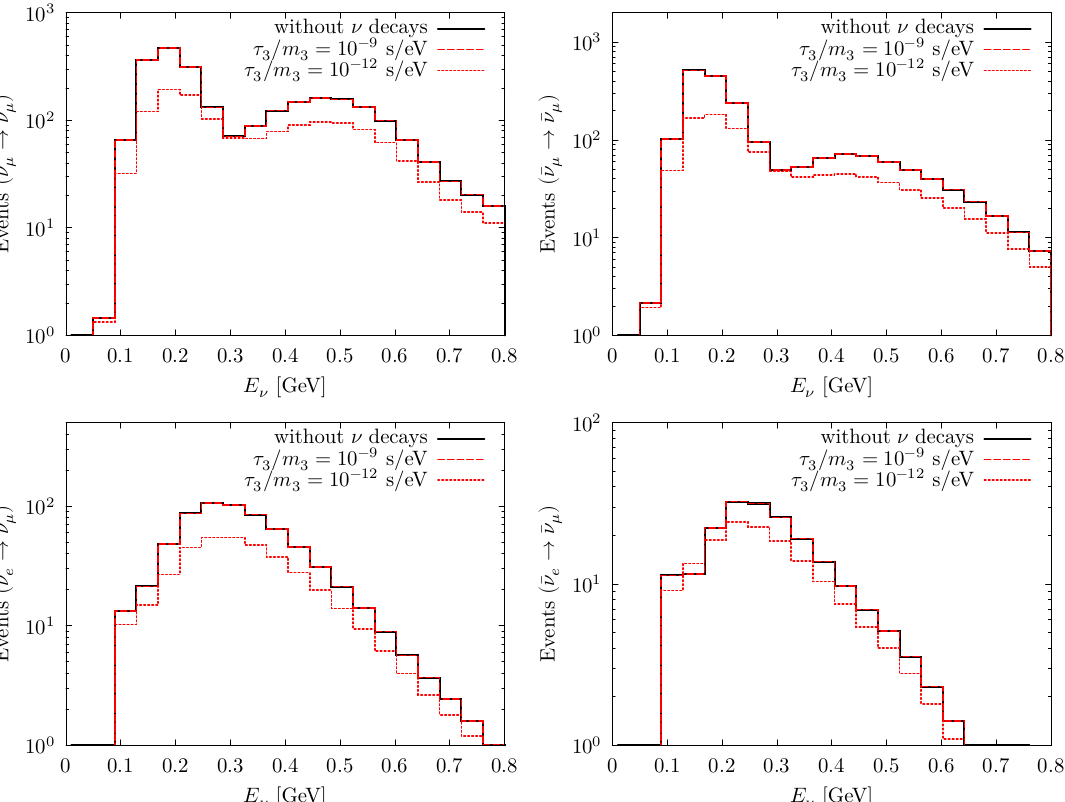
Figure 3 . The spectra with (cid:28) 3 =m 3 = 10 (cid:0) 12 s/eV (red-dotted) and = 10 (cid:0) 9 s/eV (red-dashed) and under the standard model (black) for MOMENT. Four channels are considered: (cid:23) (cid:22) ! (cid:23) (cid:22) (upper- left), (cid:22) (cid:23) (cid:22) ! (cid:22) (cid:23) (cid:22) (upper-right), (cid:23) e ! (cid:23) (cid:22) (right-left), and (cid:22) (cid:23) e ! (cid:22) (cid:23) (cid:22) (lower-right). The oscillation baseline is set at 150